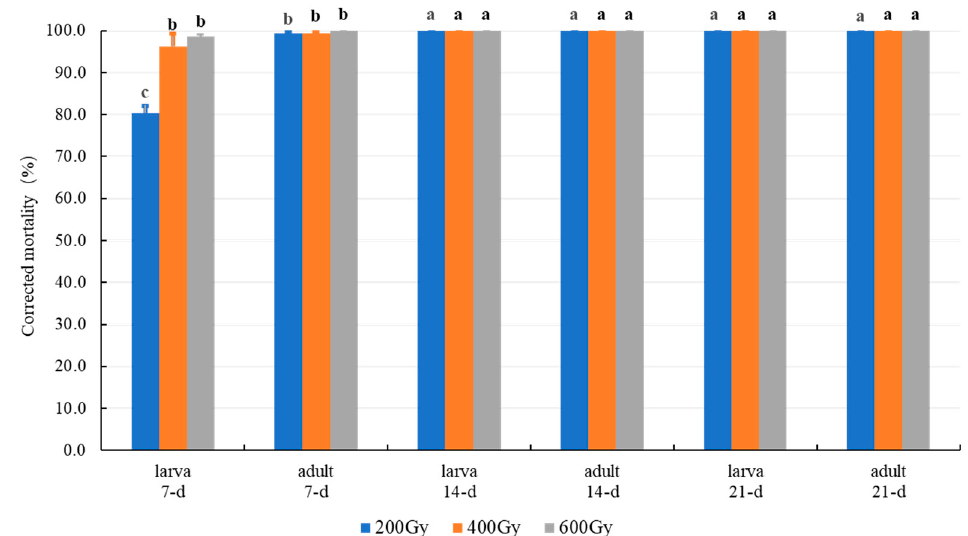
Figure 2. Percentage mortality of T. granarium adult and mixed-stage larvae treated at 24–26°Cunder 1% O 2 atmosphere for the exposure time of 7, 14, and 21-d after 200, 400, and 600 Gy gamma radiation. Means ( ± SD) followed by different letters are significantly different ( p < 0.05; Tukey test).